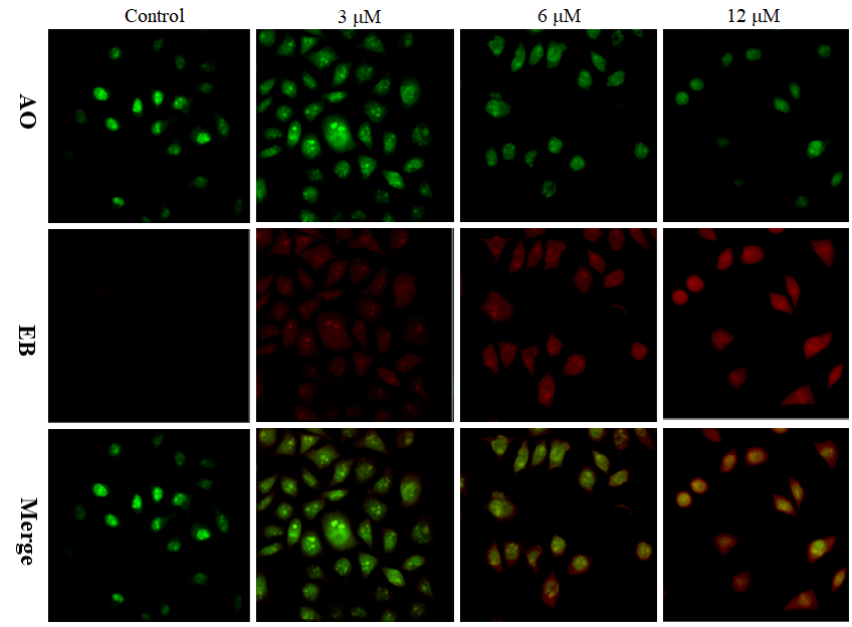
Figure 4. Compound 8f induced MCF-7 cells apoptosis. MCF-7 cells were co-cultured with com- pound 8f (0, 3, 6 and 12 μ M) for 24 h and then stained with AO/EB. In order to confirm whether tumor cell apoptosis was induced by compound 8f in tumor cells, the MCF-7 cells were stained in sequence with Annexin V-FITC (AV) and propidium iodide (PI). MCF-7 cells deal with compound 8f by gradient concentration (0, 3, 6 and 12 μ M) for 24 h, and the rates of apoptotic cells were detected by flow cytometry. As shown in Figure 5, after treatment with 3, 6 or 12 μ M of 8f for 24 h, the percentage of apoptosis cells was increased from 13.20% to 48.66%, while the control group’s percentage of apoptosis cells was only 10.54%. Notably, the apoptosis of the MCF-7 cells treatment with compound 8f increased in a dose-dependent manner. The above results suggested that compound 8f could induce apoptosis in MCF-7 cells